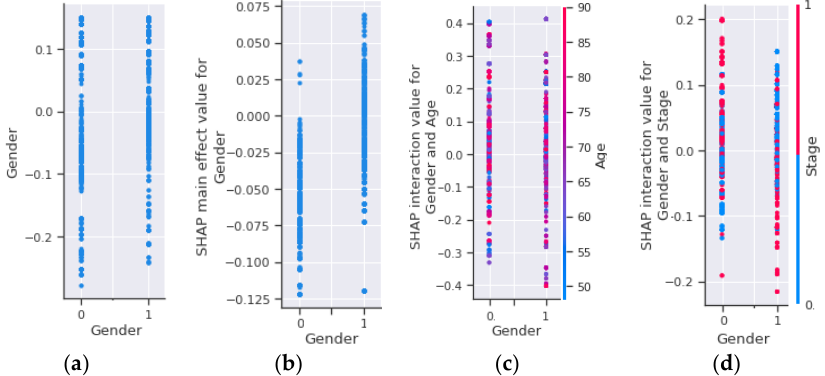
Figure 9. Dependence plots of the SHAP interaction values between stage and other important features: ( a ) SHAP value of stage; ( b ) SHAP main effect value of stage; ( c ) SHAP interaction value between stage and age; and ( d ) SHAP interaction value between stage and gender.